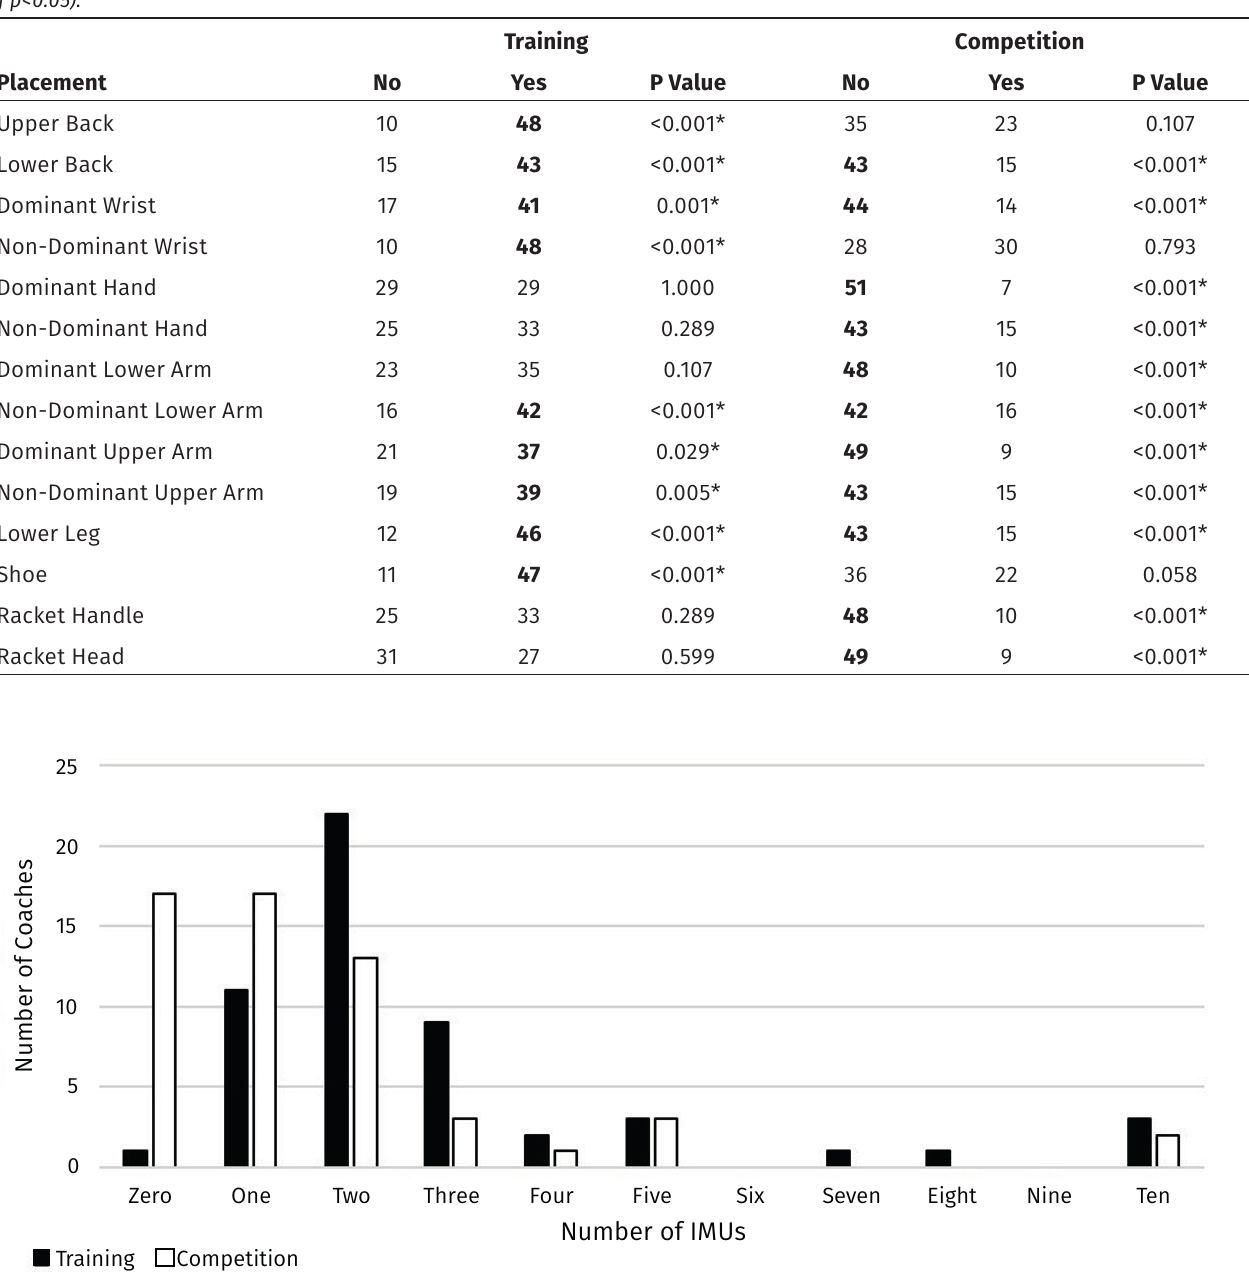
Table 4. Racket Sport Coaches Responses to the Use of IMUs at Various Body and Equipment Positions in Training and Competition (* Significance of p<0.05).